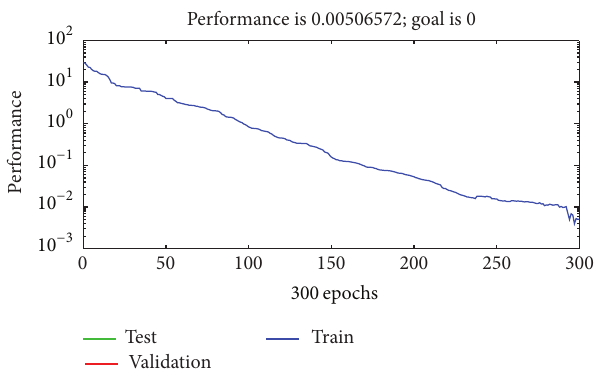
Figure 15: Performance graph of RBF network.